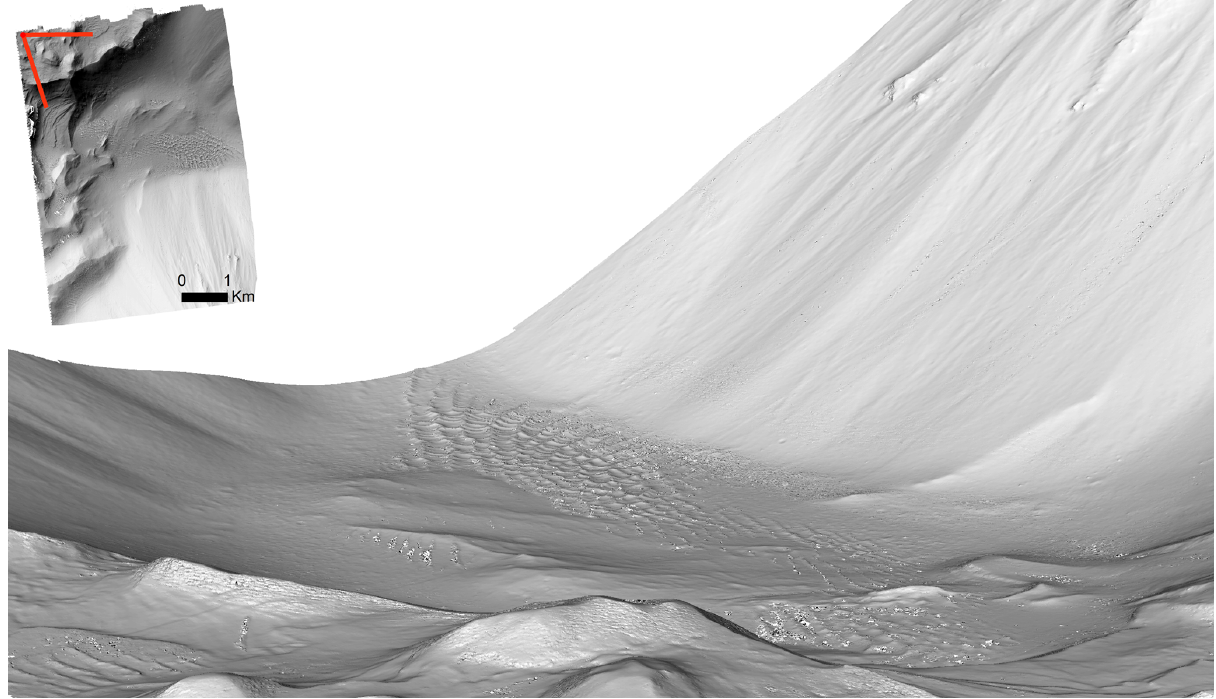
Figure 5. Oblique view of a region of layered terrain in a Noctis Labyrinthus pit (site 2). A complex landform assemblage is visible, including aeolian dunes, scarps, and hill-slope processes. View generated from a 2mpixel − 1 hillshade of AU DEM 2, draped over the AU DEM itself and visualized in ArcScene . Inset map shows AU DEM 2 hillshade in plan view, approximate viewpoint marked in